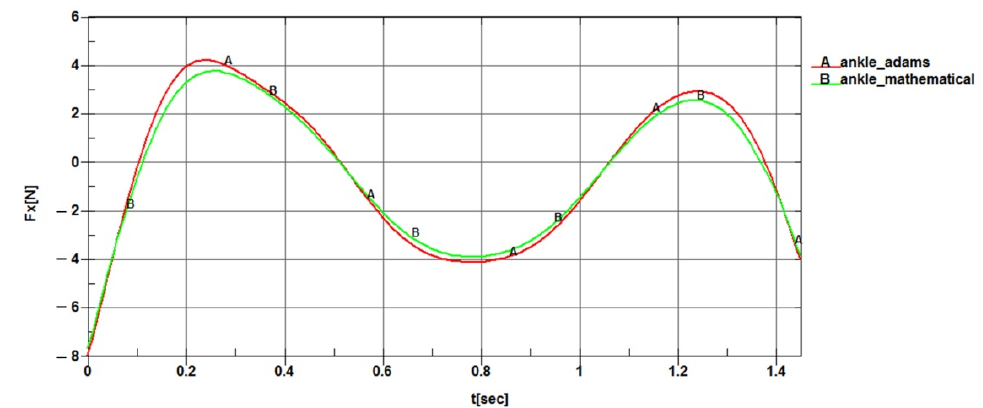
Figure 13. Connection forces component on x-axis for ankle joint vs. time (without ground contact).